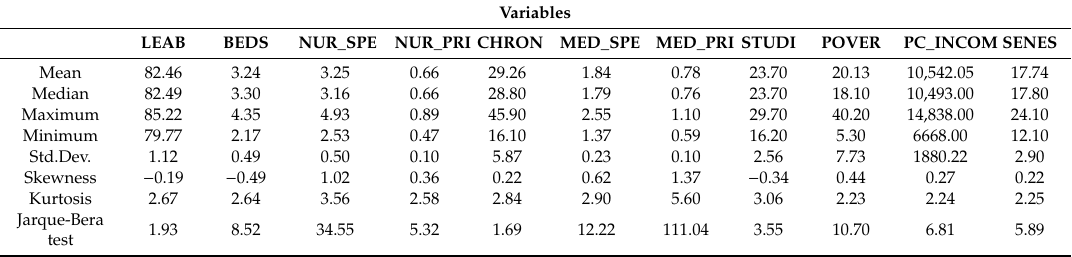
Table 2. Variables and summary statistics. Source : Own